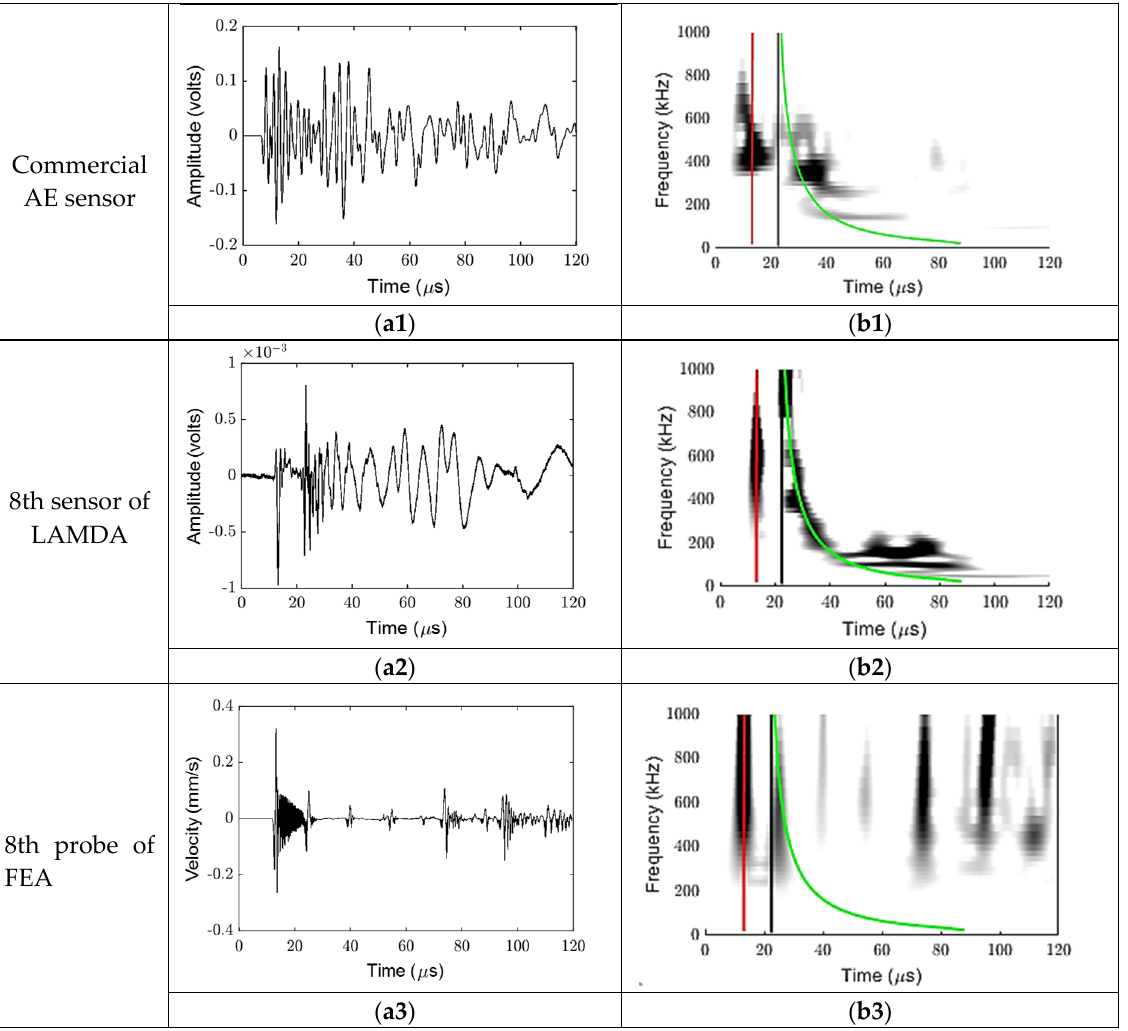
Figure 6. Longitudinal PLB results. Top row shows waveform ( left ) and corresponding time–fre- quency plot ( right ) for commercial AE sensor . Middle row as for top row but for LAMDA sensor. Bottom row as for top row but for FEA prediction corresponding to radial velocity component.